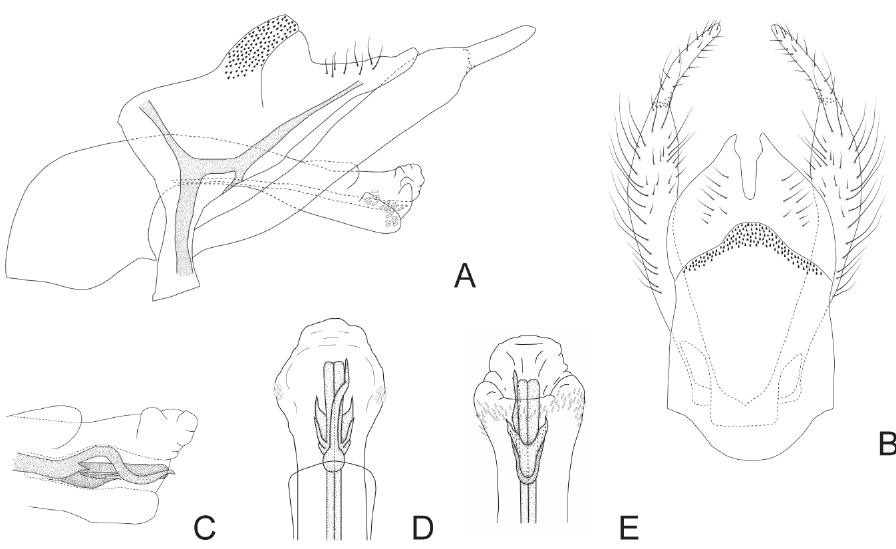
Figure 3. Male genitalia of Smicridea ( Rhyacophylax ) brasiliana A segments IX, X, inferior appendages and phallus, lateral view B segments IX, X and inferior appendages, dorsal view C tip of the phallus, lateral view (lateral spines removed) D tip of the phallus, dorsal view E tip of the phallus, ventral